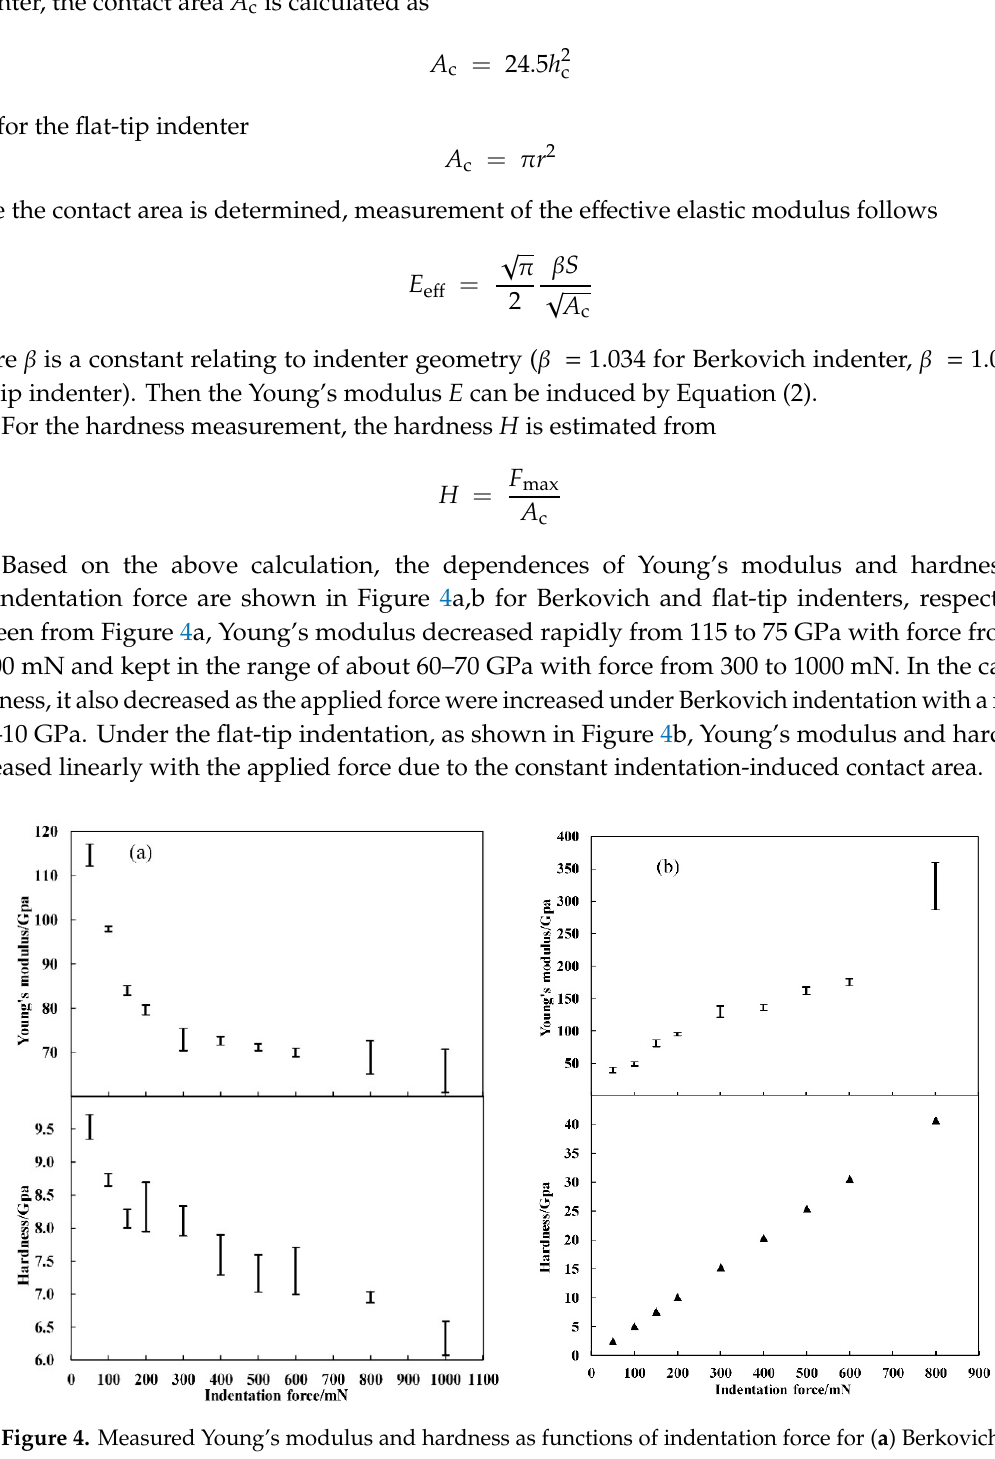
Figure 4. Measured Young’s modulus and hardness as functions of indentation force for ( a ) Berkovich indenter and ( b ) flat-tip indenter. The error bar means that the data was obtained from the five repeated measurement under one single